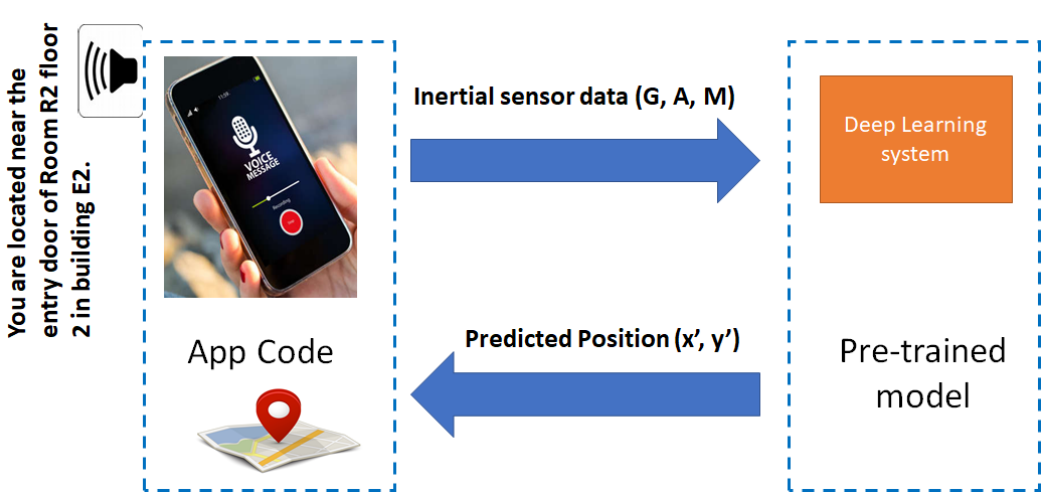
Figure 2. Interaction between the smartphone app and the pre-trained model.